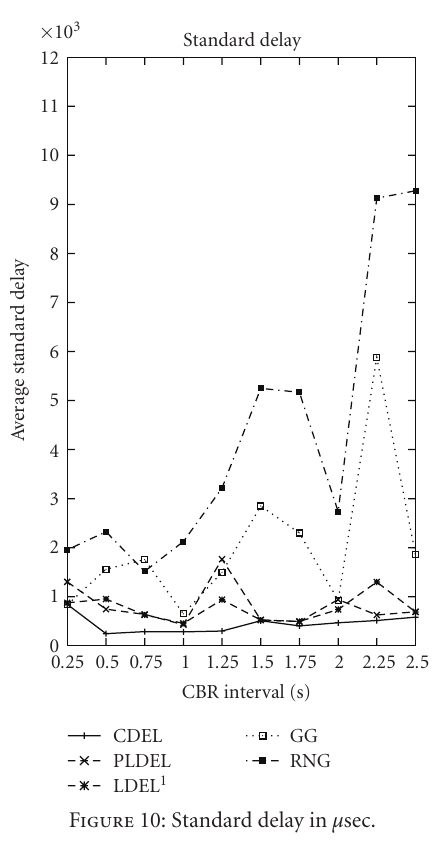
Figure 10: Standard delay in μ sec.